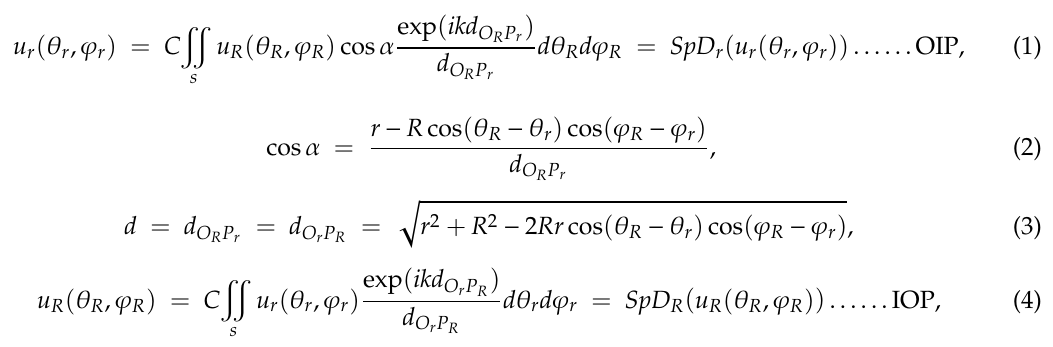
Figure 2. The filtering diffusion process.